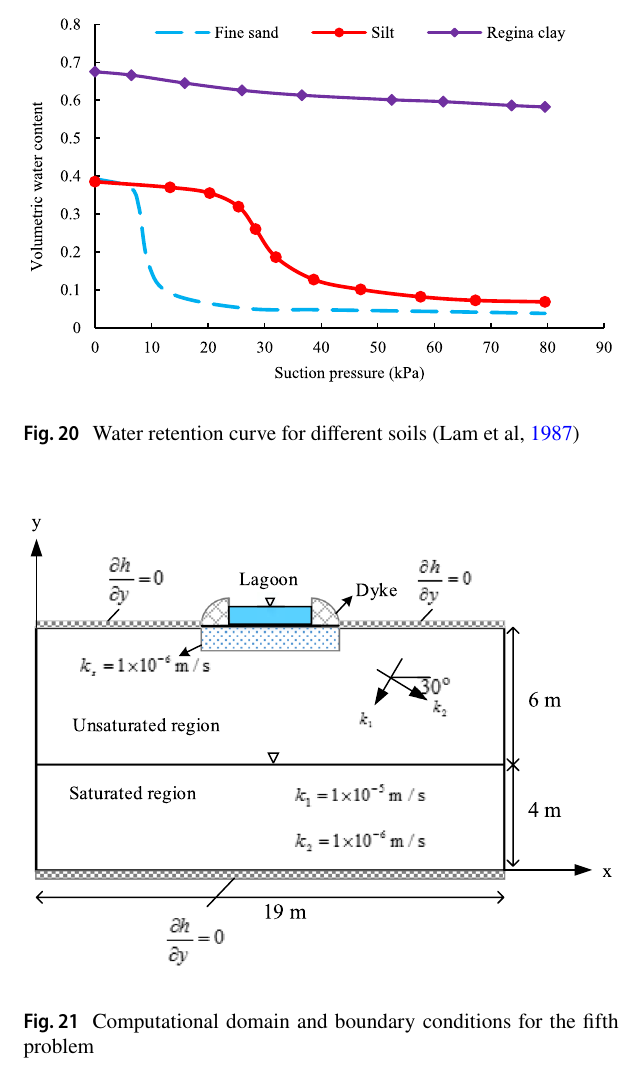
and k 1 and 2 are the major